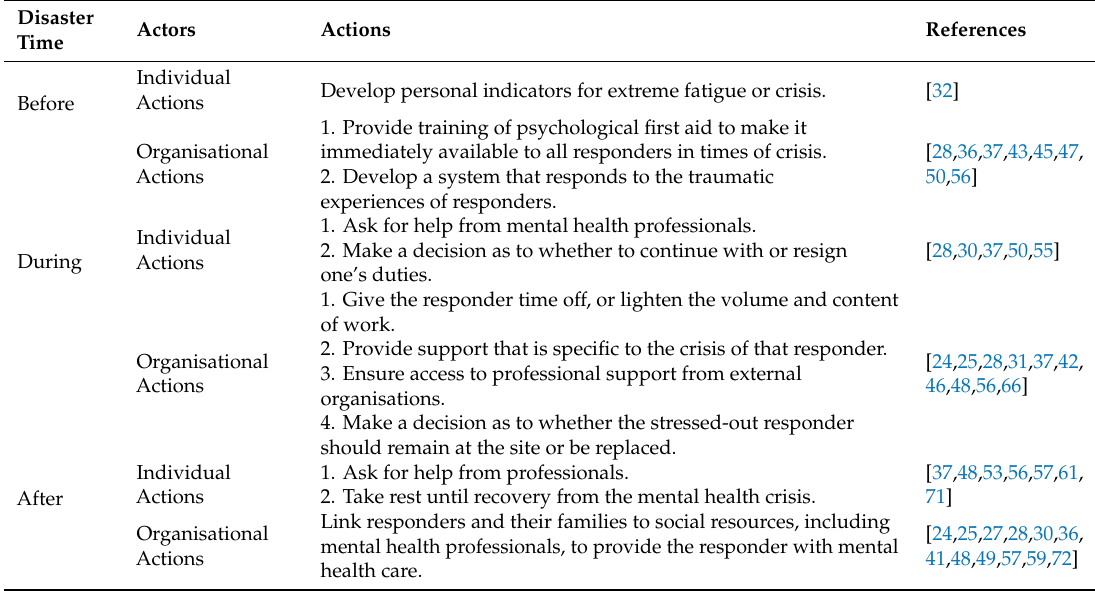
Table 3. Actions for Goal 3: Responding to crises and alleviating